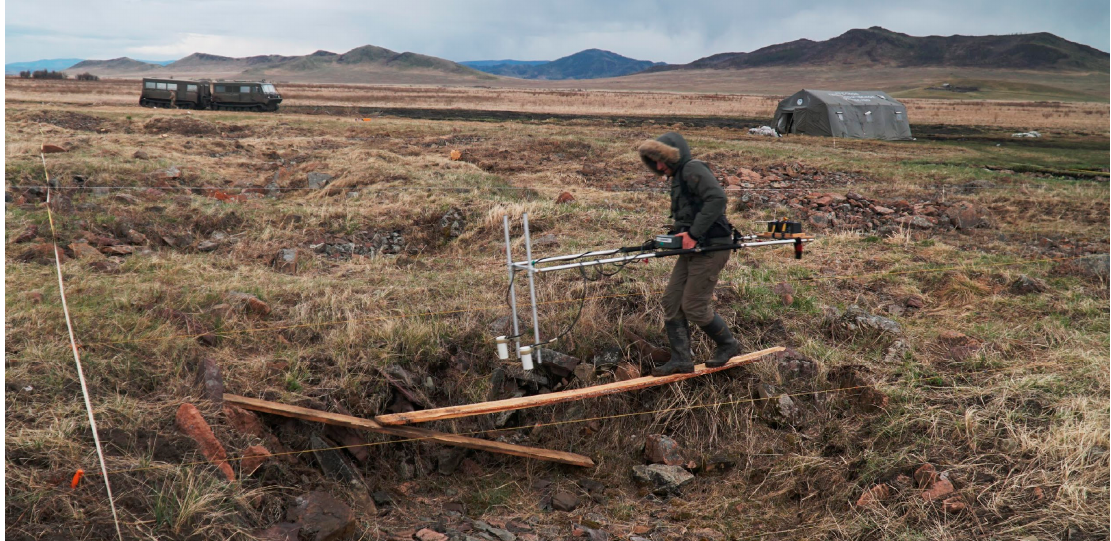
Figure 8. Wooden planks and a light weight geomagnetometry device made the survey on the burial mound possible. Ground-penetrating radar and geoelectric resistivity would not have been possible under these circumstances. Photo: T. Wallace.